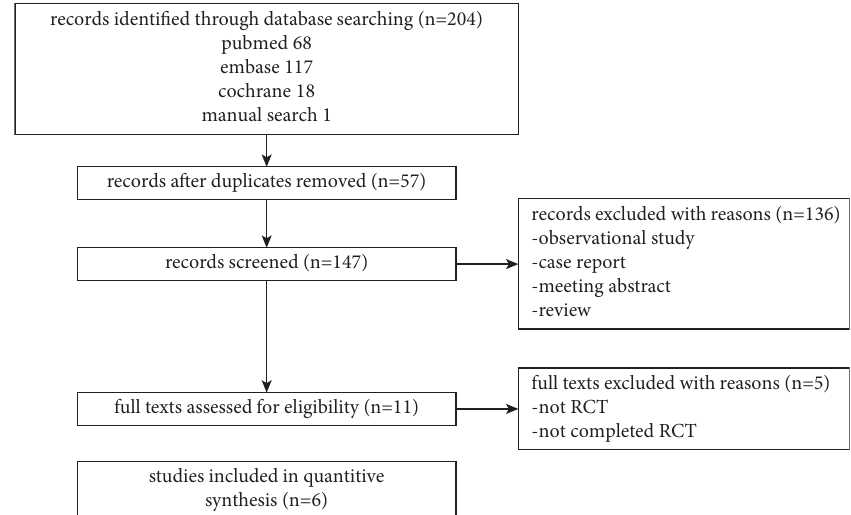
Figure 1: Study selection